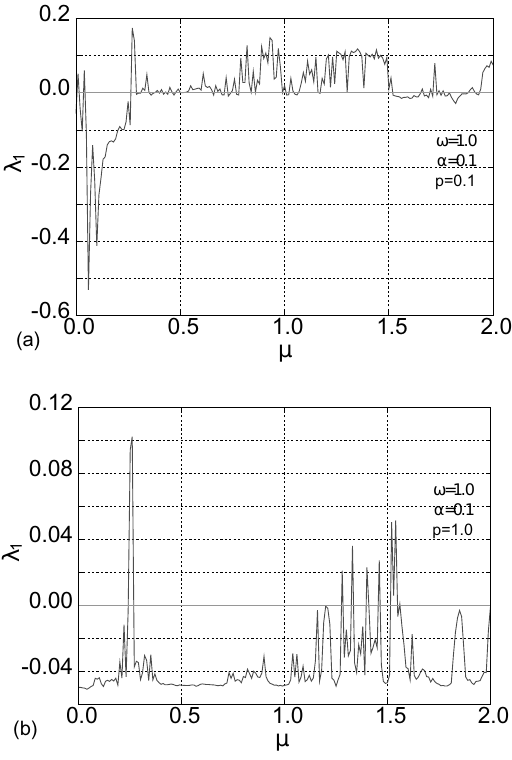
Fig. 4. Lyapunov exponents for δ = − 1 , γ = 1 and p = 0 . 1 (Fig. 4(a)), p = 1 . 0 (Fig.